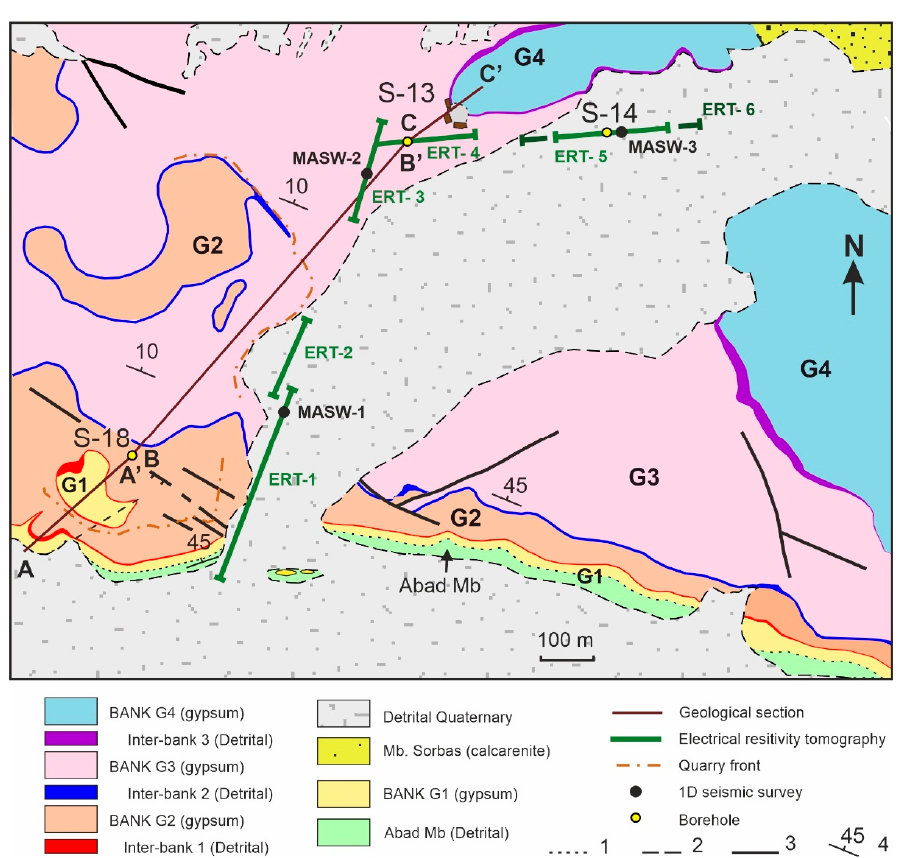
Figure 5. Geological map of the studied area (E sector). The position of the geological sections (A–A’, B–B’. C–C’), ERT profiles, and MASW points are indicated. Legend: 1, stratigraphic contact; 2,